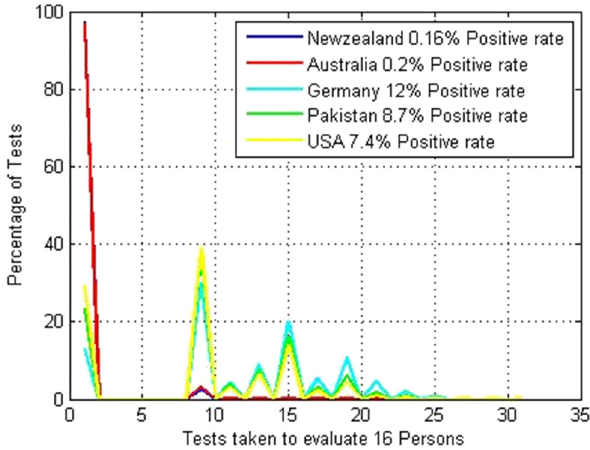
Figure 12: Test predictions for fi ve major countries hit as of 21/04/2021 ( The COVID + ve ratio is adapted from https:// ourworldindata.org/coronavirus - testing )